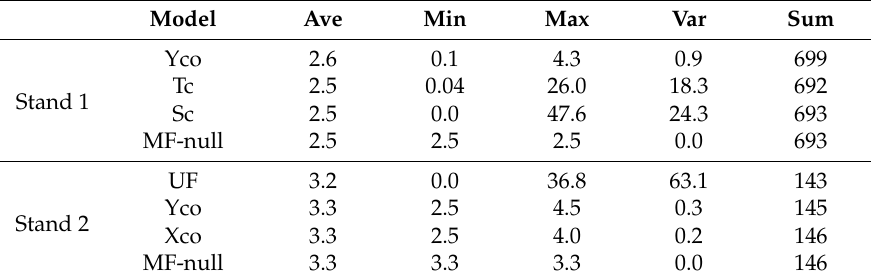
Table 5. Descriptive statistics for estimated fecundities for adjusted models in two stands.